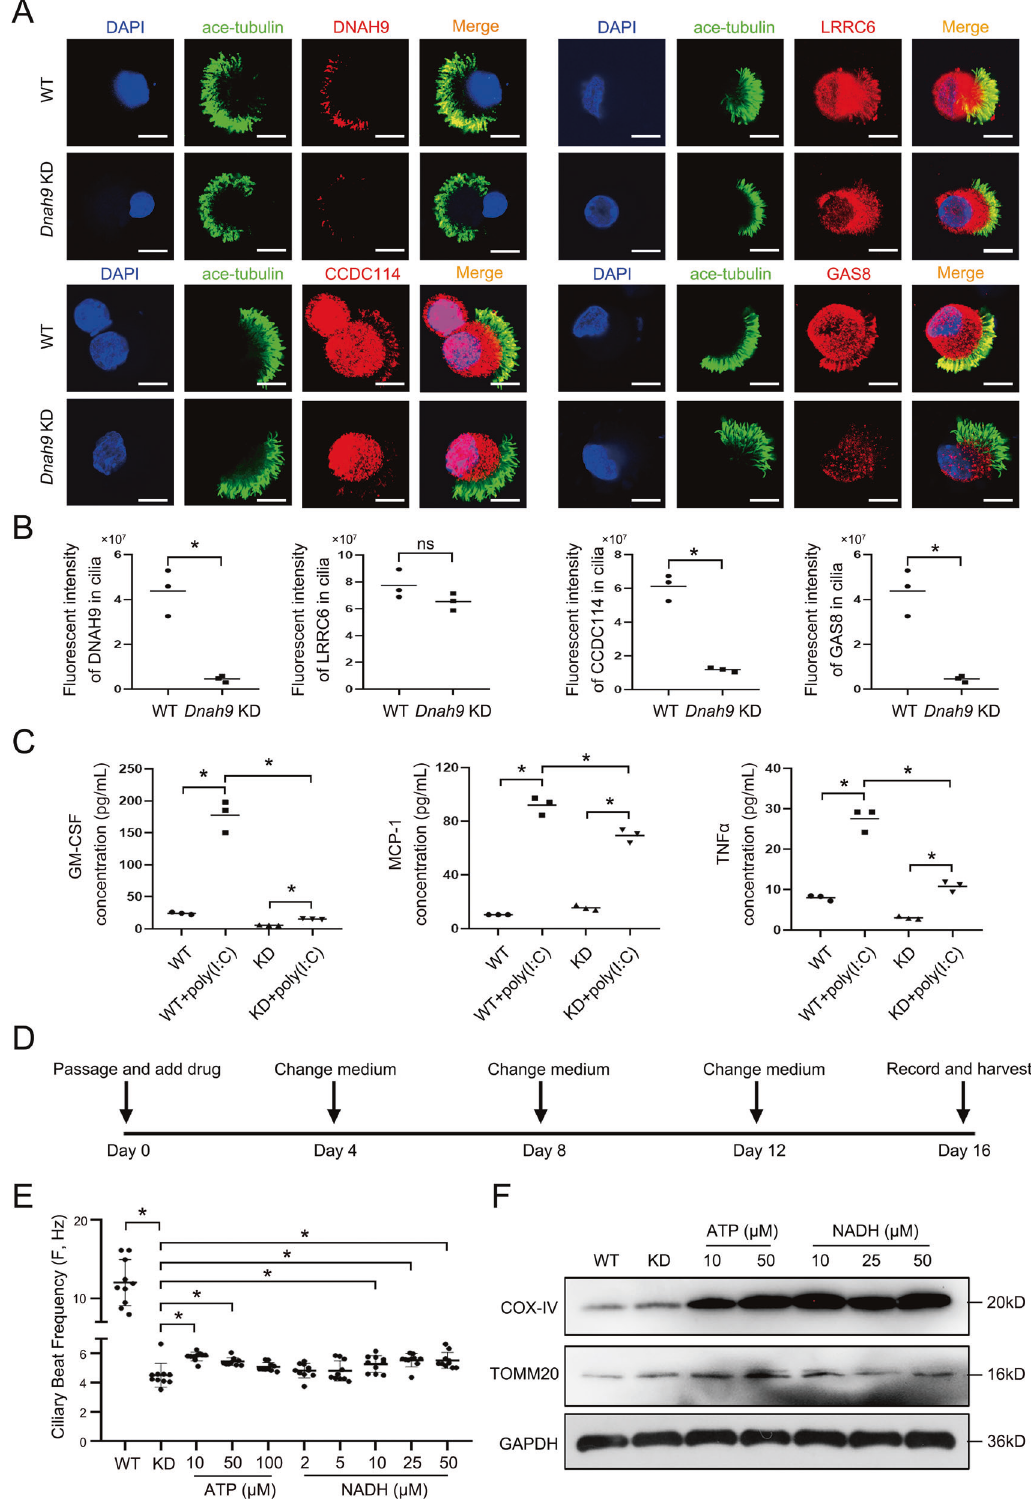
Fig. 8 Drugs targeting mitochondrial could rescue the cilia beating and related phenotypes. A Expression analysis of DNAH9, CCDC114, LLRC6, and GAS8 in ciliated epithelium digested from WT and Dnah9 KD mouse airway organoid. Green, ace-tubulin; red, DNAH9, LRRC6, CCDC114, and GAS8; blue, DAPI. Scale bar = 10 µm. B The quanti fi ed DNAH9, LRRC6, CCDC114, and GAS8 fl uorescent intensities in cilia analyzed by ImageJ in ( A ). * P < 0.05; ns no signi fi cance, n = 3 per group. C The expression of immune factors in mouse airway organoid after 4-day poly (I:C) treatment. * P < 0.05; n = 3 per group. D Stepwise protocol for the organoid drug screen. E CBF of Dnah9 KD mouse airway organoid after 16-day drug treatment. * P < 0.05, n = 10 per group. F Western blot of TOMM20 and COX-IV in KD mouse airway organoid treated with ATP (10 µM, 50 µM) and NADH (10 µM, 25 µM, 50 µM) and WT organoid.